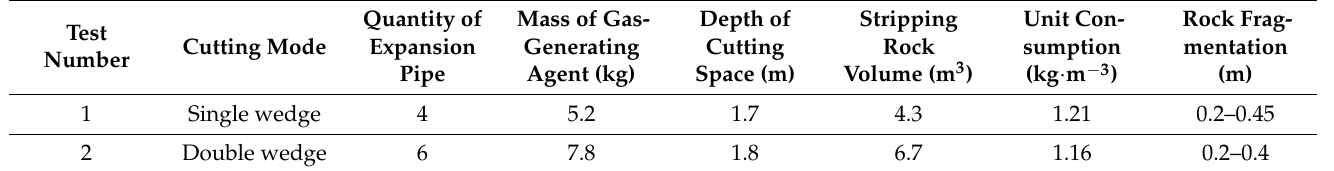
Table 4. Results of cutting excavation tests.